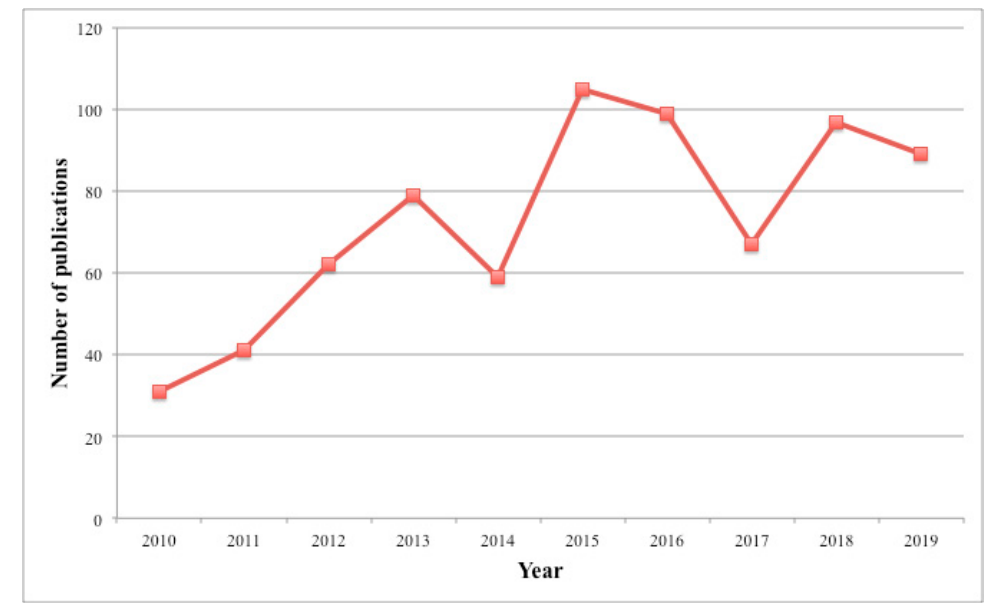
Figure 2. The number of papers that discussed on LiDAR and flood applications by year in the Scopus database.